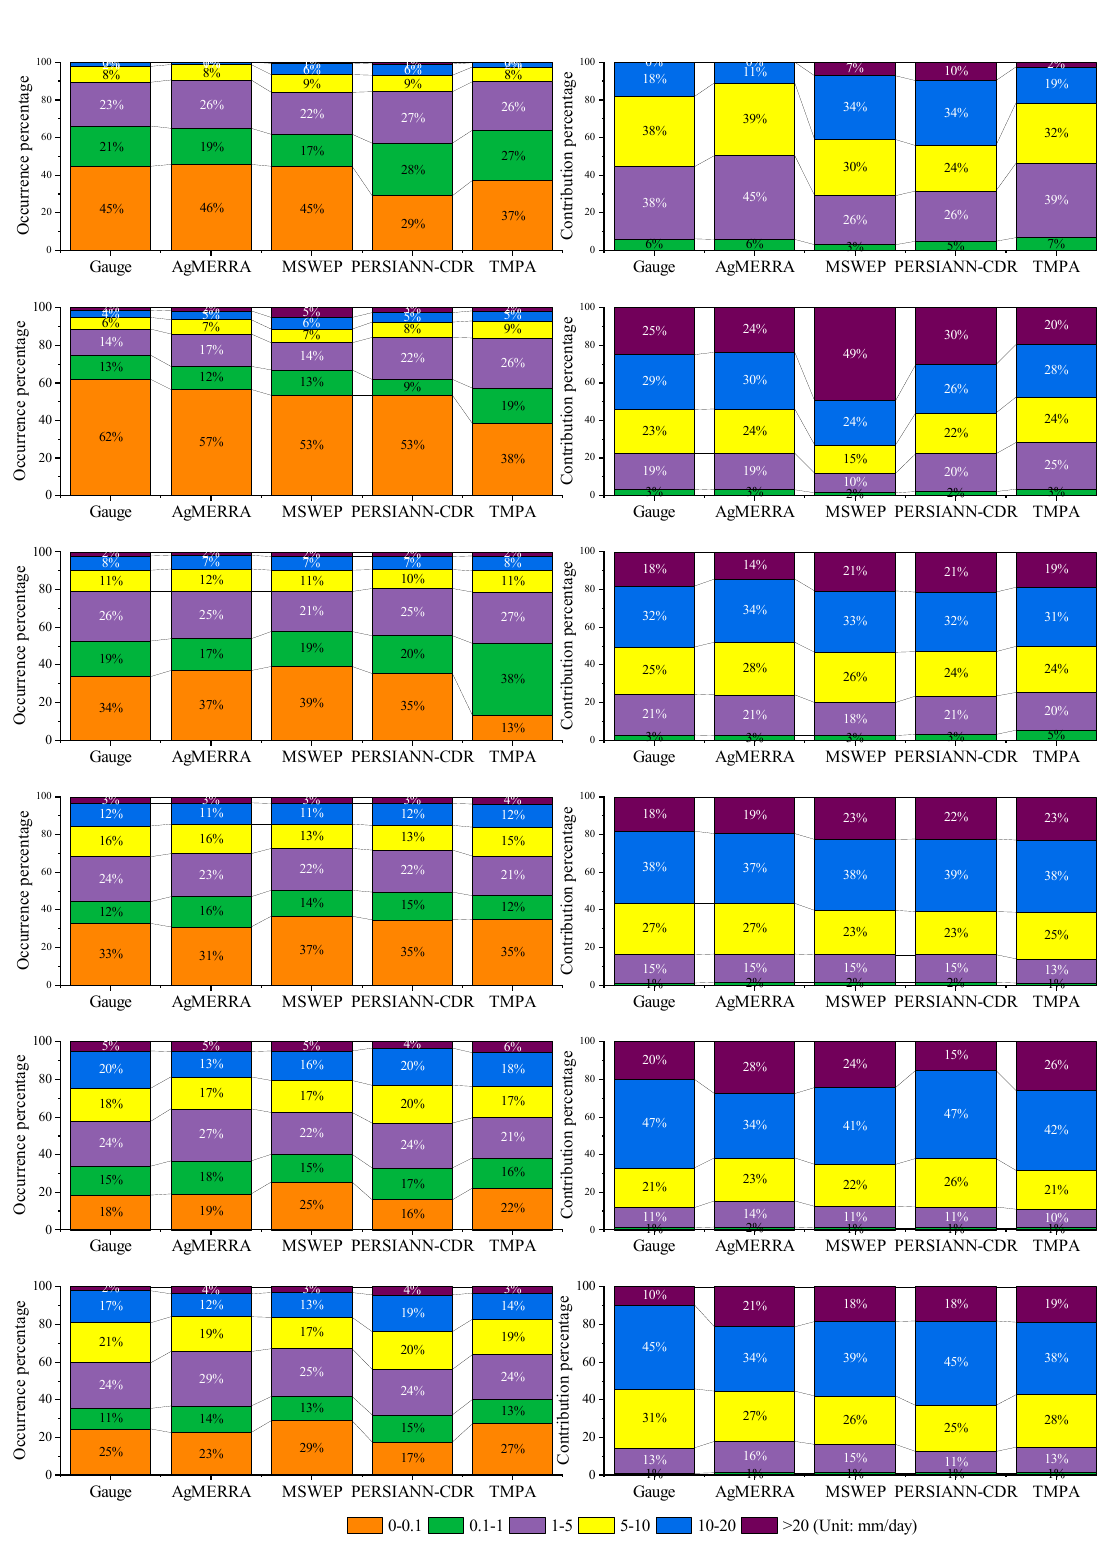
Figure 4. The intensity distribution of daily precipitation in different ranges (0~0.1, 0.1~1, 1~5, 5~10, 10~20, and >20 mm/day), and their relative contribution to the total precipitation amounts during the period 1998 to 2007 in six climatic zones (Line 1: ET, Line 2: Dwc, Line 3: Cwb, Line 4: Cwa, Line 5: Aw, and Line 6: Am).